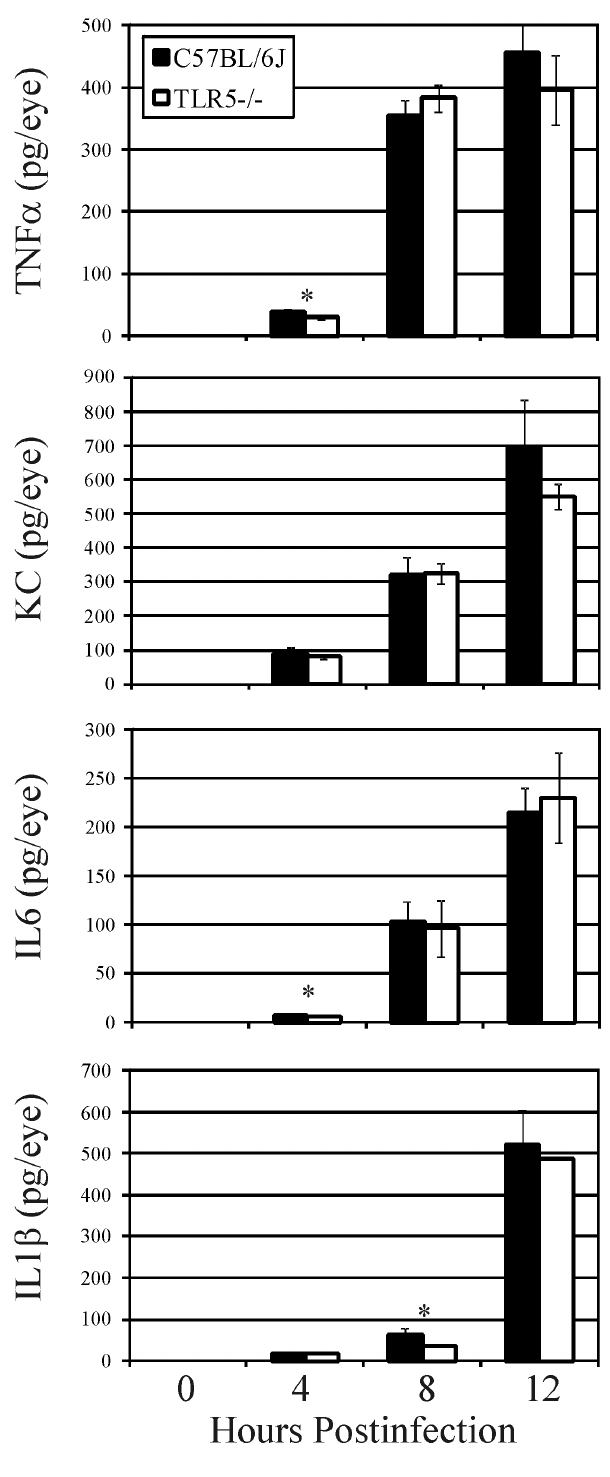
Figure 5. Influence of TLR5 on proinflammatory mediator expression during experimental B. cereus endophthalmitis. C57BL/6J and TLR5 2 / 2 mouse eyes were injected with 100 CFU B. cereus . Ocular proinflammatory cytokines and chemokines were analyzed by sandwich ELISA. Overall, similar levels of TNF a , KC, IL6, and IL1 b were synthesized in infected eyes of C57BL/6J mice compared with that in infected eyes of TLR5 2 / 2 mice, suggesting that the absence of TLR5 did not alter the inflammatory mediator response during infection. Values represent the mean 6 SD for N $ 4 per group for at least 2 separate experiments. *P # 0.05. doi:10.1371/journal.pone.0100543.g005 PLOS ONE |